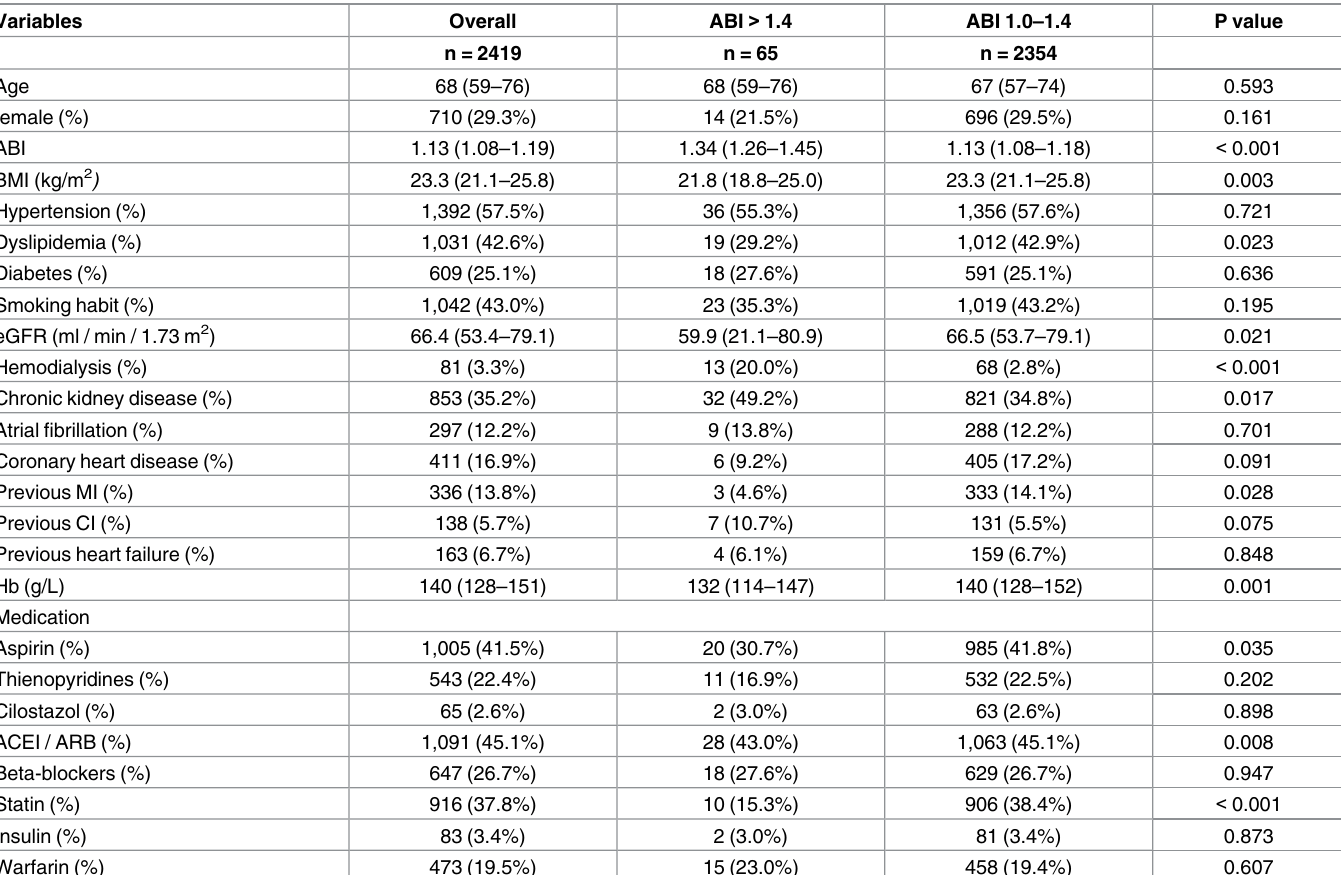
Table 1. Baseline